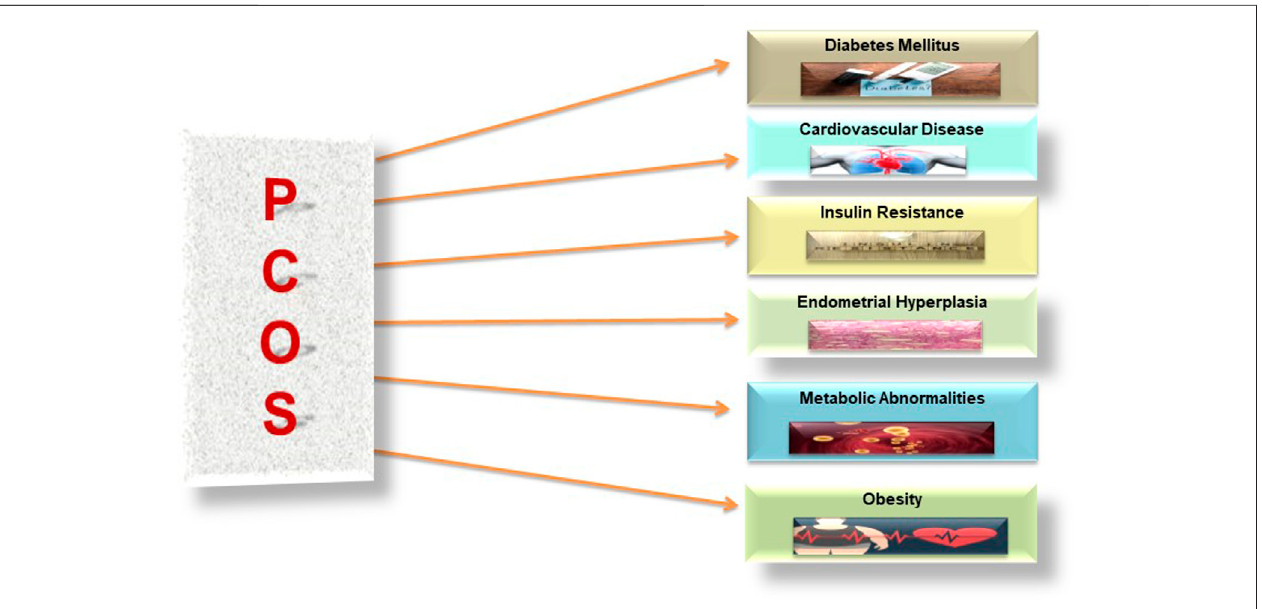
FIGURE 7 | Associated risk factors of